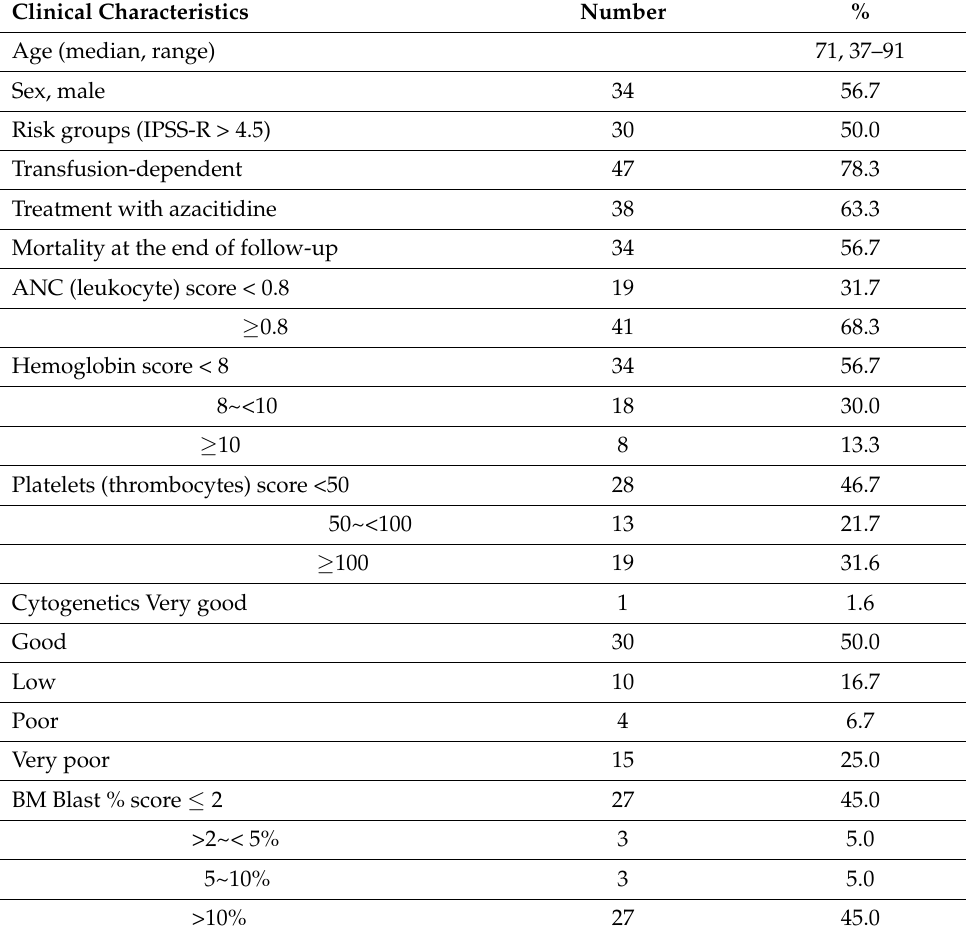
Table 1. Baseline clinical characteristics of 60